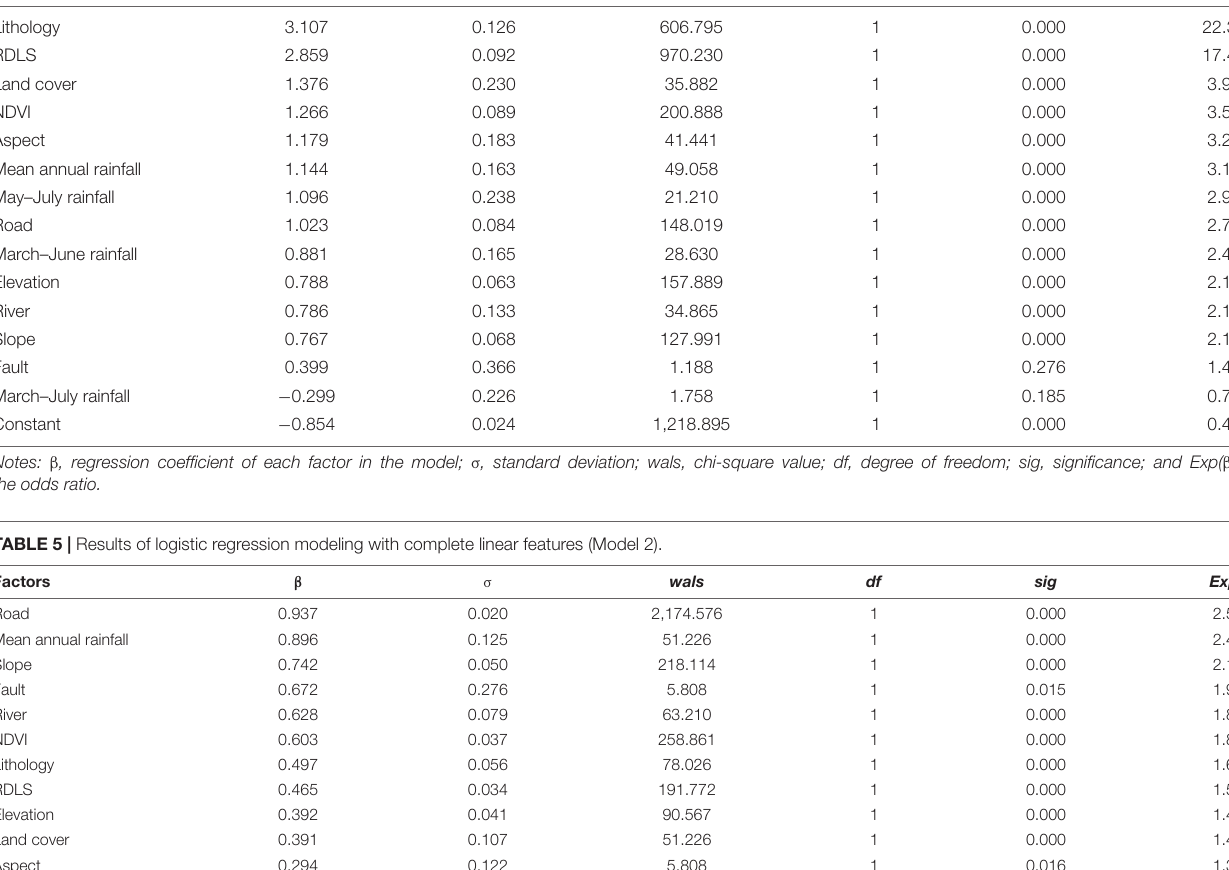
TABLE 4 | Results of logistic regression modeling only with main linear features (Model 1). Factors